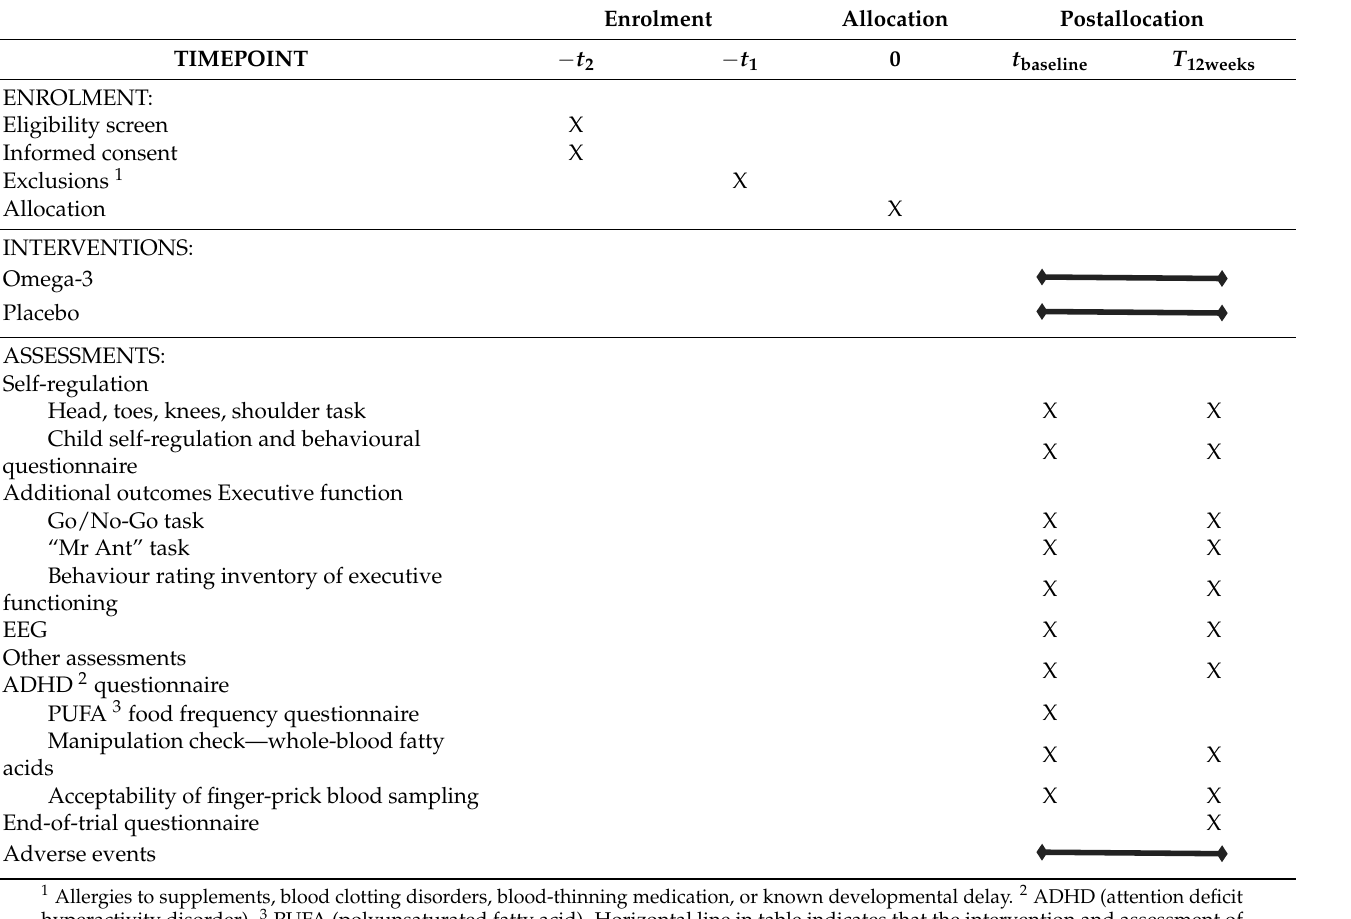
Table 2. Schedule of enrolment, intervention and assessments.